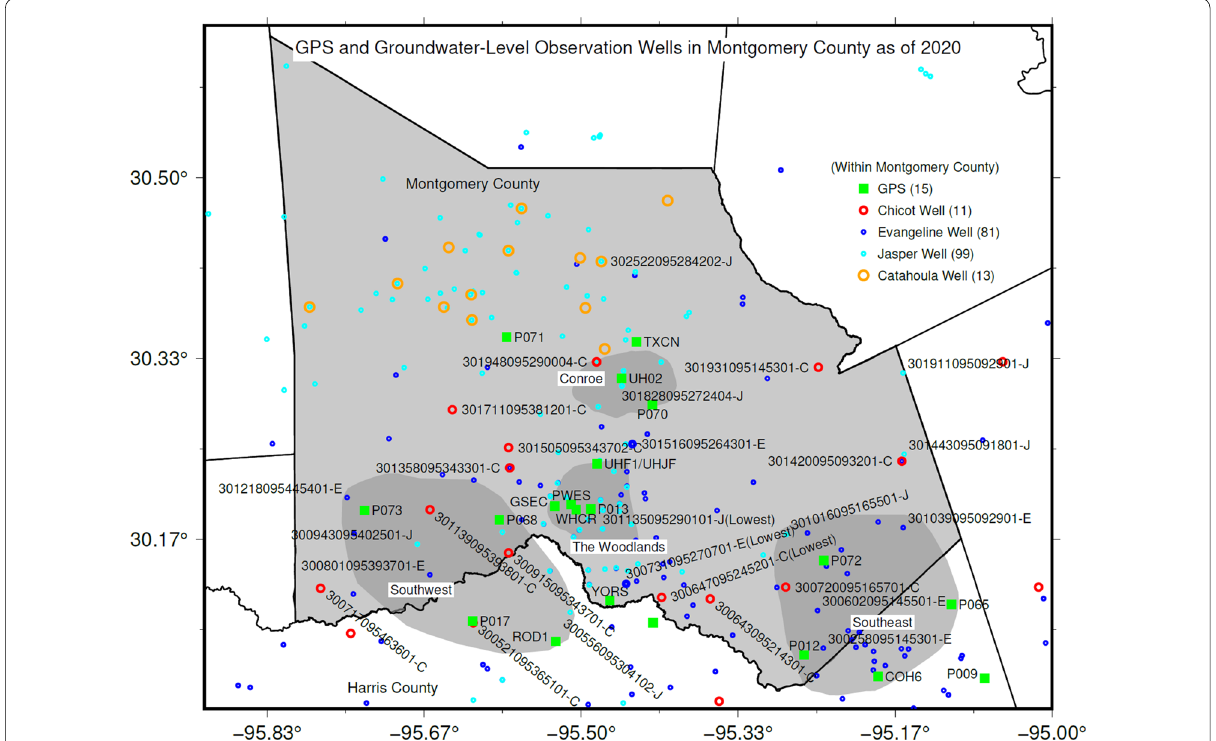
Fig. 5 Map showing the locations of GPS and groundwater-level observation wells in Montgomery County and adjacent areas. A letter is added to the end of USGS well ID. “C” represents a Chicot well. “E” represents an Evangeline well. “J” represents a Jasper